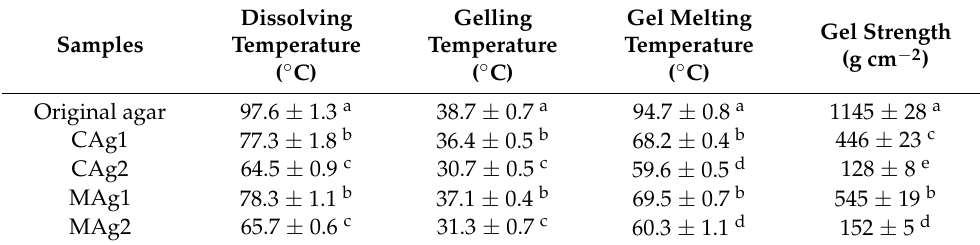
Table 1. Effect of the synthetic method on the physicochemical properties of carboxymethyl